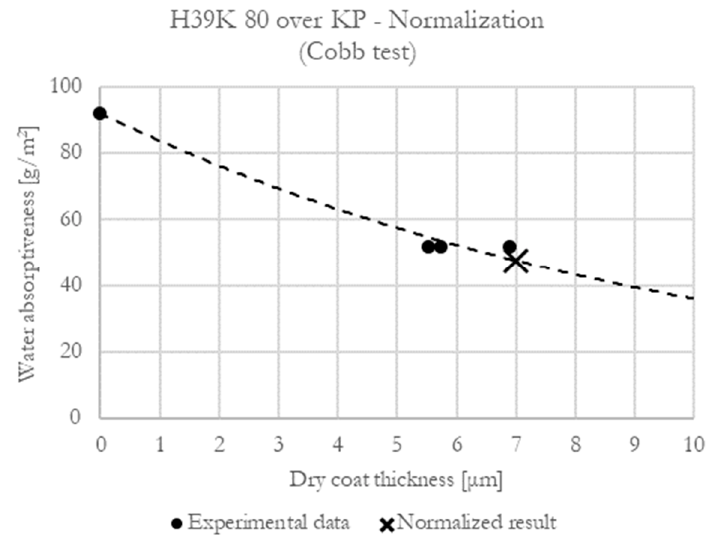
Figure 1. Representative normalization curve (H39K 80 over KP substrate—Cobb test).